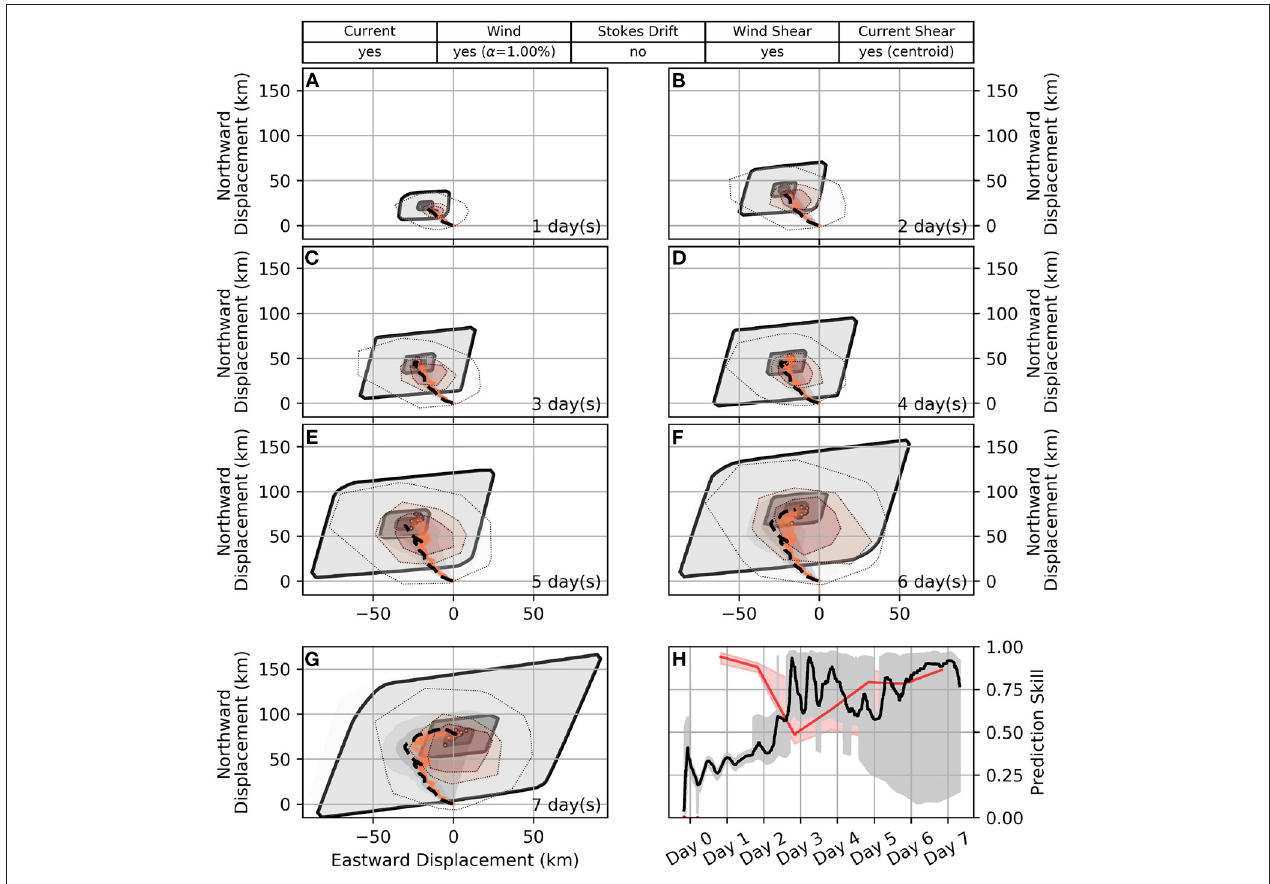
FIGURE 10 | Daily predicted tracks of the SCT drifters for 7 days after deployment using the indicated optimal forcing combination (A–G) , and a time series of model skill during this period (H) . Same layout as Figure 9 .